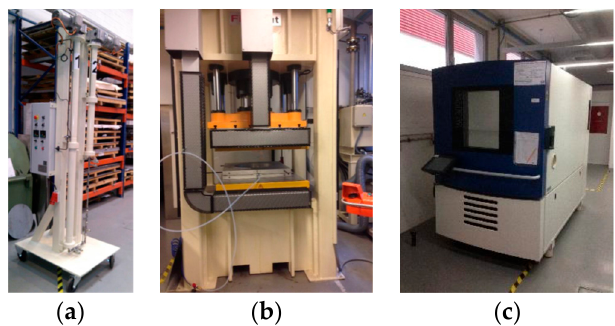
Figure 2. ( a ) Injection equipment; ( b ) press equipment; ( c ) climatic chamber.